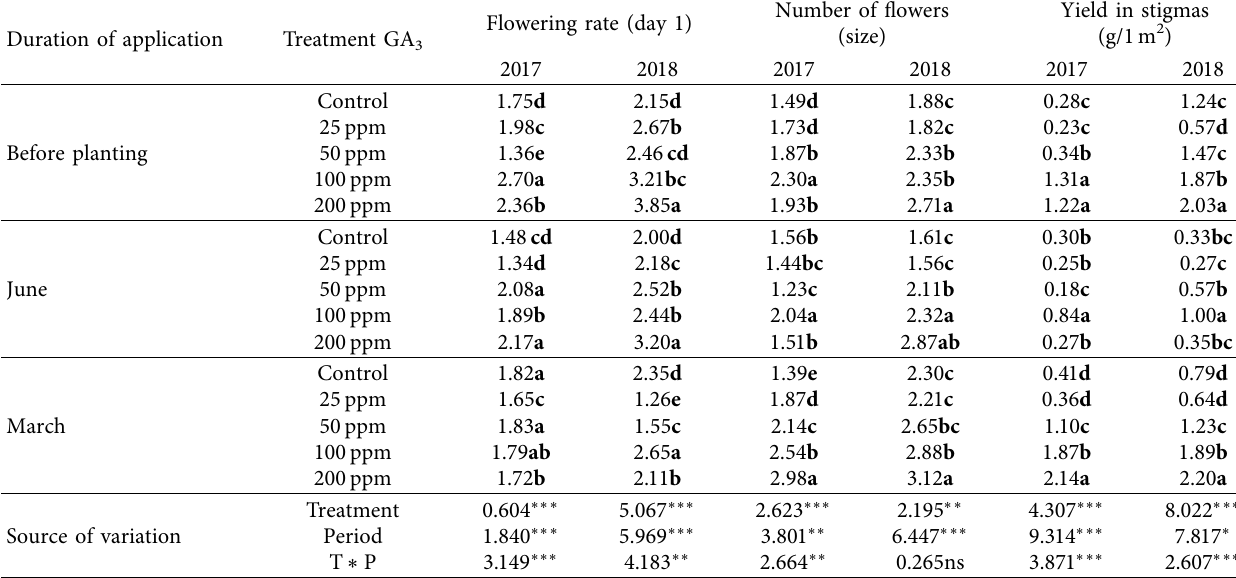
Table 2: Effect of different GA 3 concentrations and duration of application on flowering rate, number of flowers, and stigmata yield. Values with the same letter in each application period in the column are not significantly different ( p � 0 . 05); ns: not significant; ∗ significant at 5%; ∗∗ significant at 1%; ∗∗∗ significant at